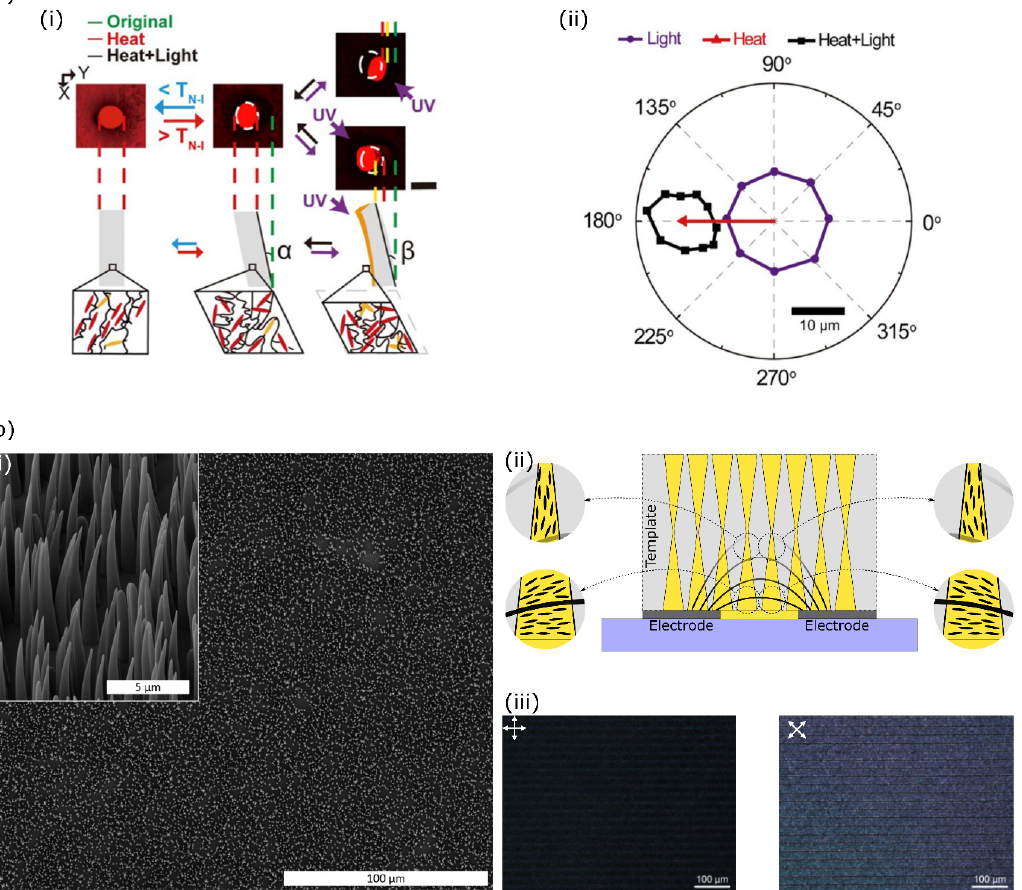
Figure 7. ( a ) Multiresponsive LCE micropillars. The LC alignment in each pillar is controlled by an external magnet during polymerisation of the LC mixture and programs a temperature-triggered actuation direction into each pillar (( i ), left and middle). Shining a UV light on any side of the (thermally actuated) pillar causes a bend in the direction of the light-source (( i ), middle and right). The LCE pillars can actuate in response to light or heat, and to a combination of the two, potentially introducing asymmetry in the actuation pattern ( ii ). Adapted with kind permission from ref [62]. Copyright 2018, The Authors. ( b ) SEM micrograph of microsized, tapered LC cilia as observed from above ( i ) and at a tilt of 45 ◦ (( i ), inset). An electric field, as schematically indicated by equipotential field lines, realigned the LC monomers prior to- and during polymerisation so that symmetry in alignment was broken and the actuation direction was programmed into the polymer cilia, which is always perpendicular to the electrode lanes ( ii ). Polarised microscopy confirmed that the LC director in the self-standing cilia could be harnessed over large areas and conformed to the expected orientation shown in ii ( iii ). Adapted from ref [61]. Copyright 2022, Eindhoven University of